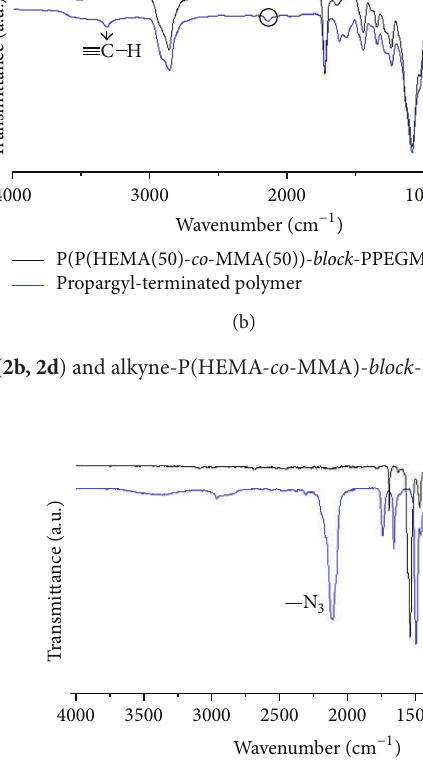
Figure 10: The FT-IR spectra of 2,3,4,5,6-pentafluorobenzyl chlo- ride and azido-2,3,4,5-pentafluorobenzene.